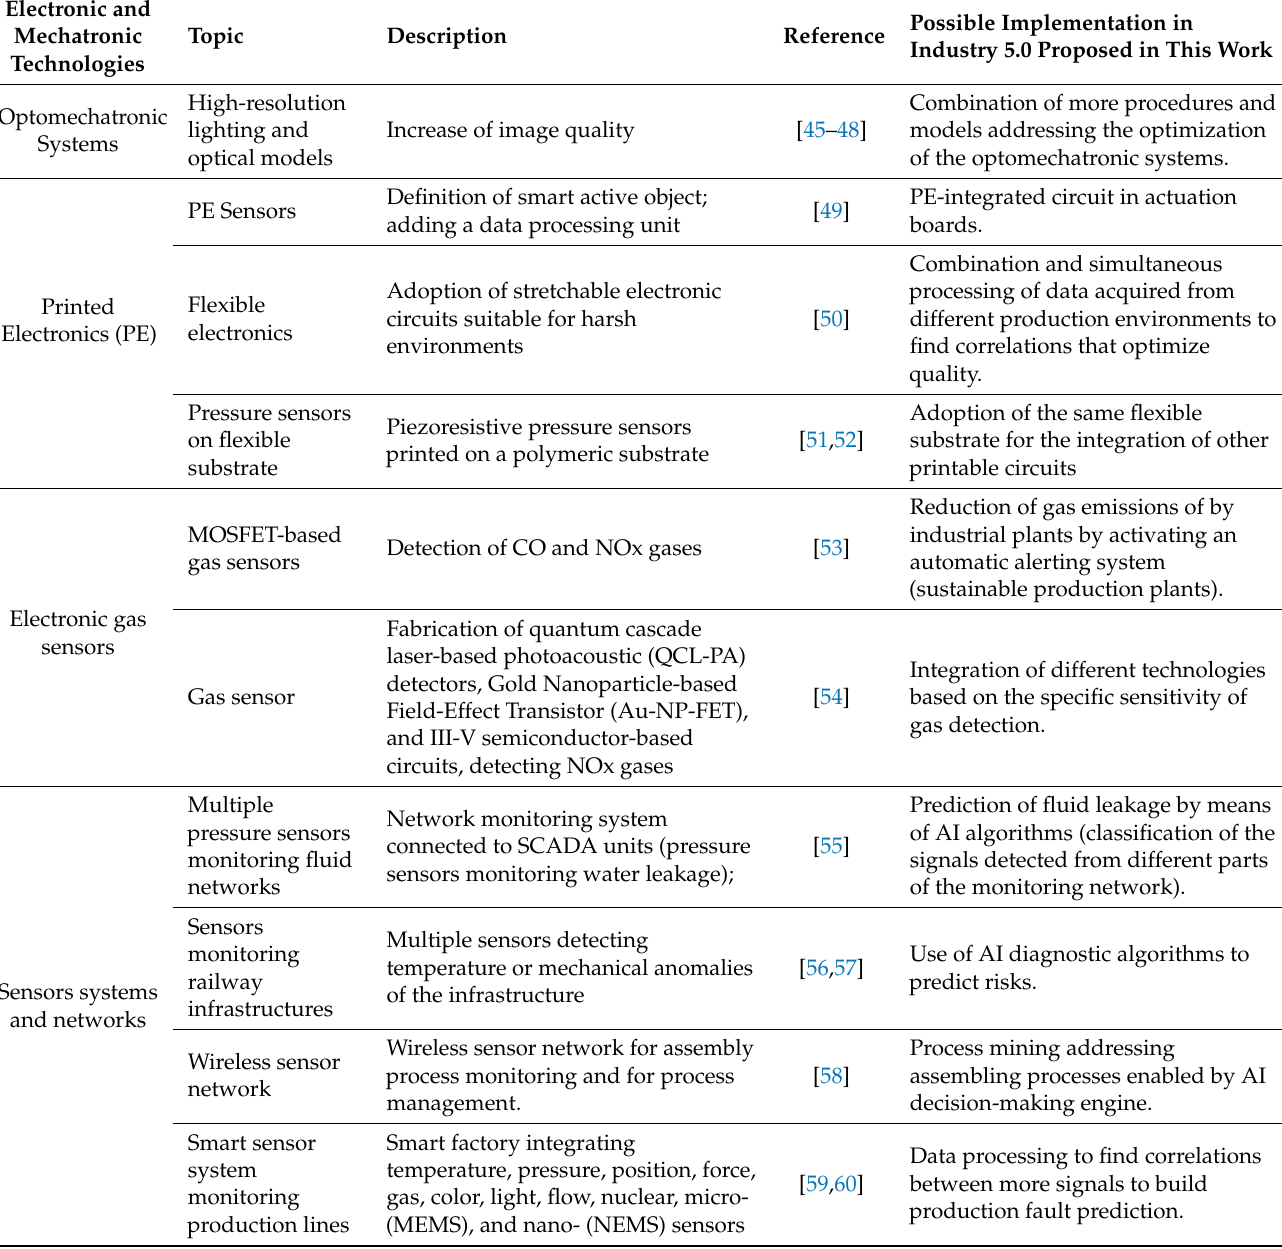
Table 2. State of the art: some electronic and mechatronic sensors adaptable for industrial applications in Industry 5.0